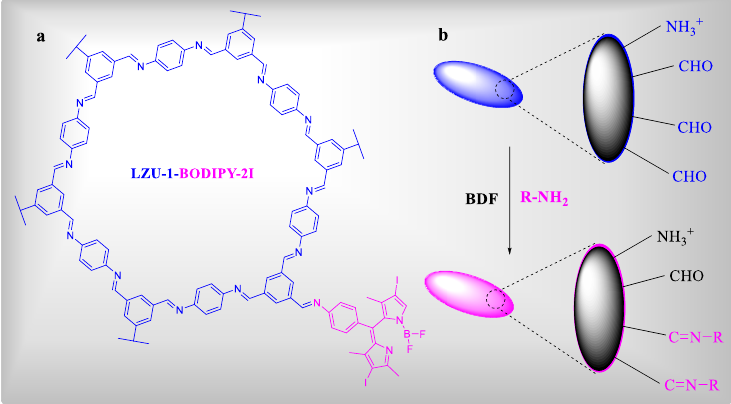
Figure 7. ( a ) COF LZU-1 with a particle size of 110 nm. ( b ) BODIPY PS effectively nanosized on LZU-1 nanoparticles [101].